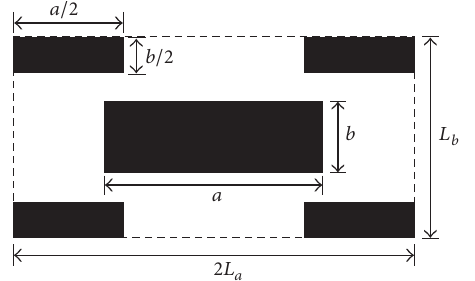
Figure 8: A staggered (anisotropic) unit cell with dimensions 𝜙 = 0.6 , 𝑎/𝑏 = 3 , and 𝐿